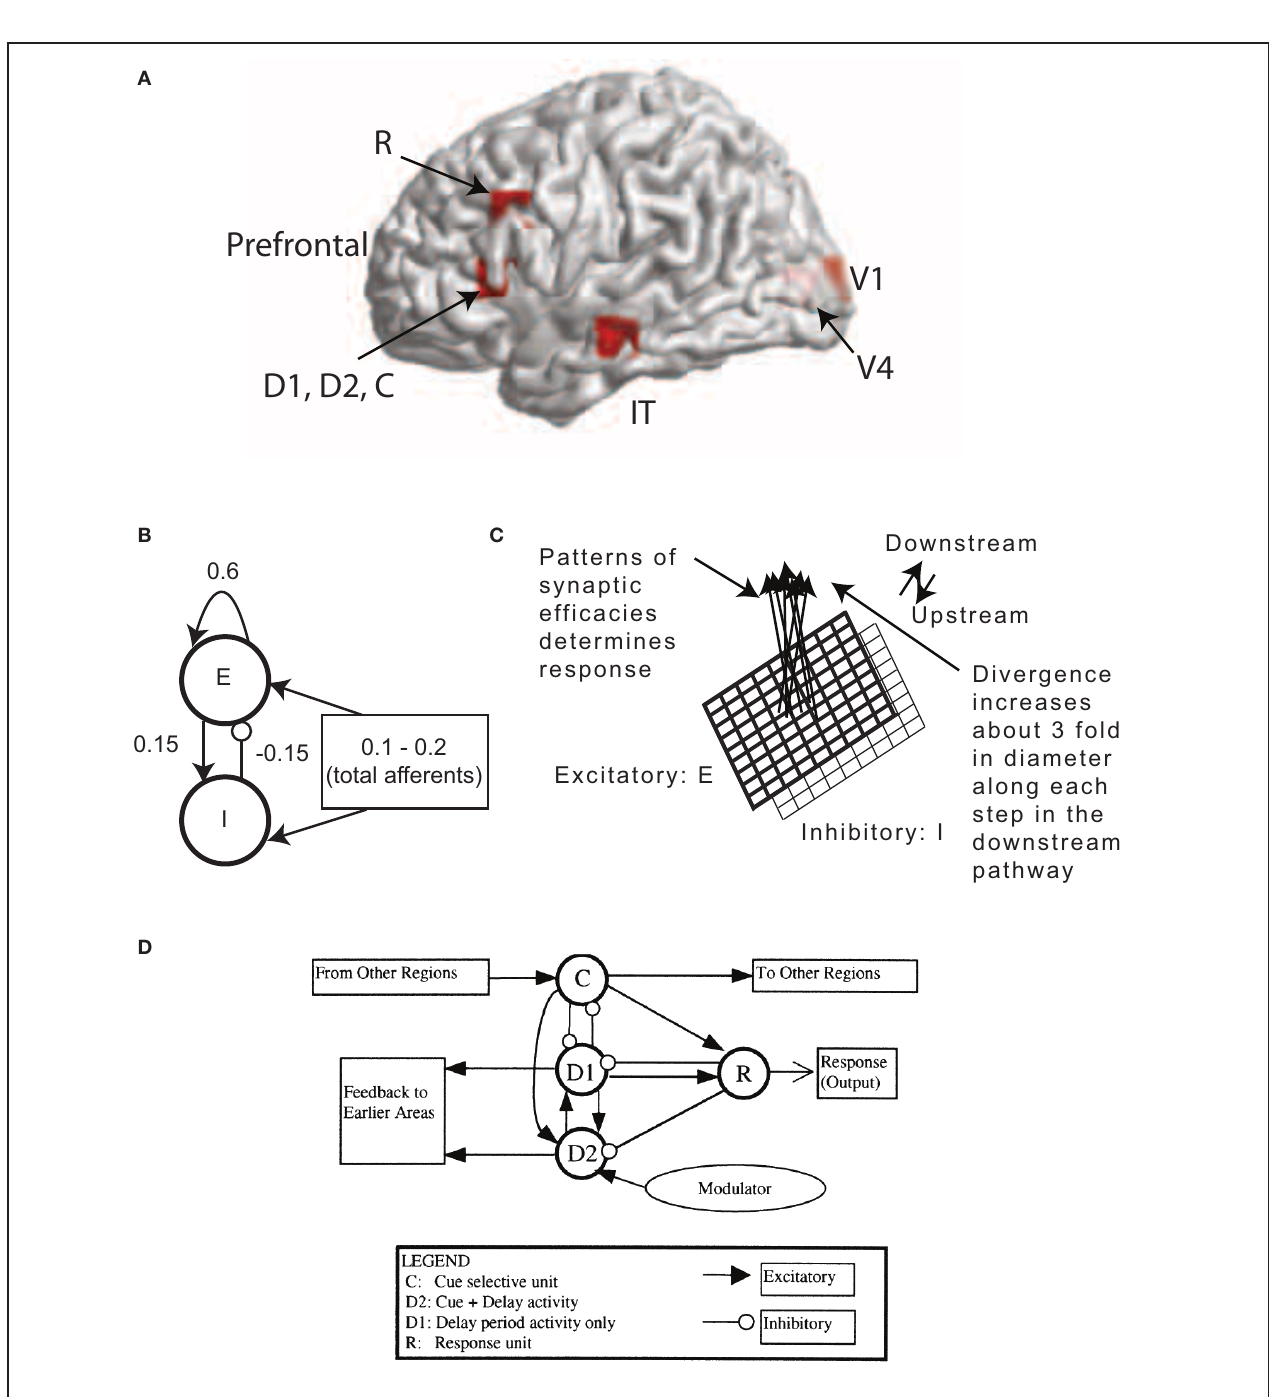
(C) A cortical area is modeled by a 9 × 9 set of basic units. The excitatory population is shown in bold lines above the inhibitory